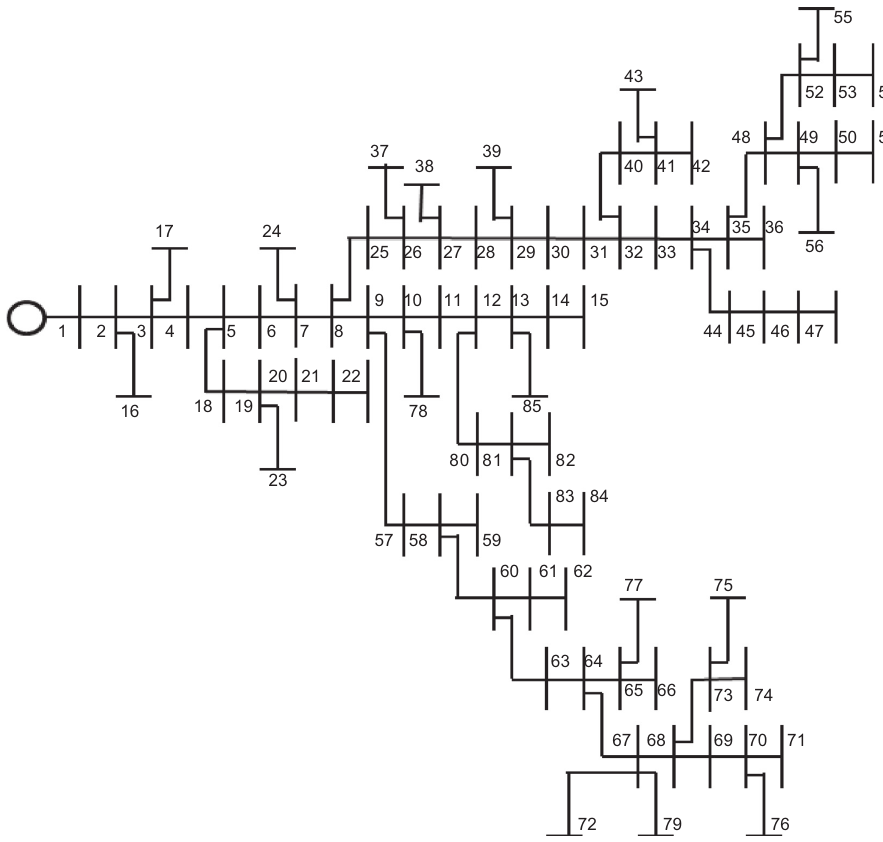
Figure 9 IEEE-85 bus radial distribution test system. Figure 3. Grid topology of the IEEE 85-bus system for bipolar power flow applications.